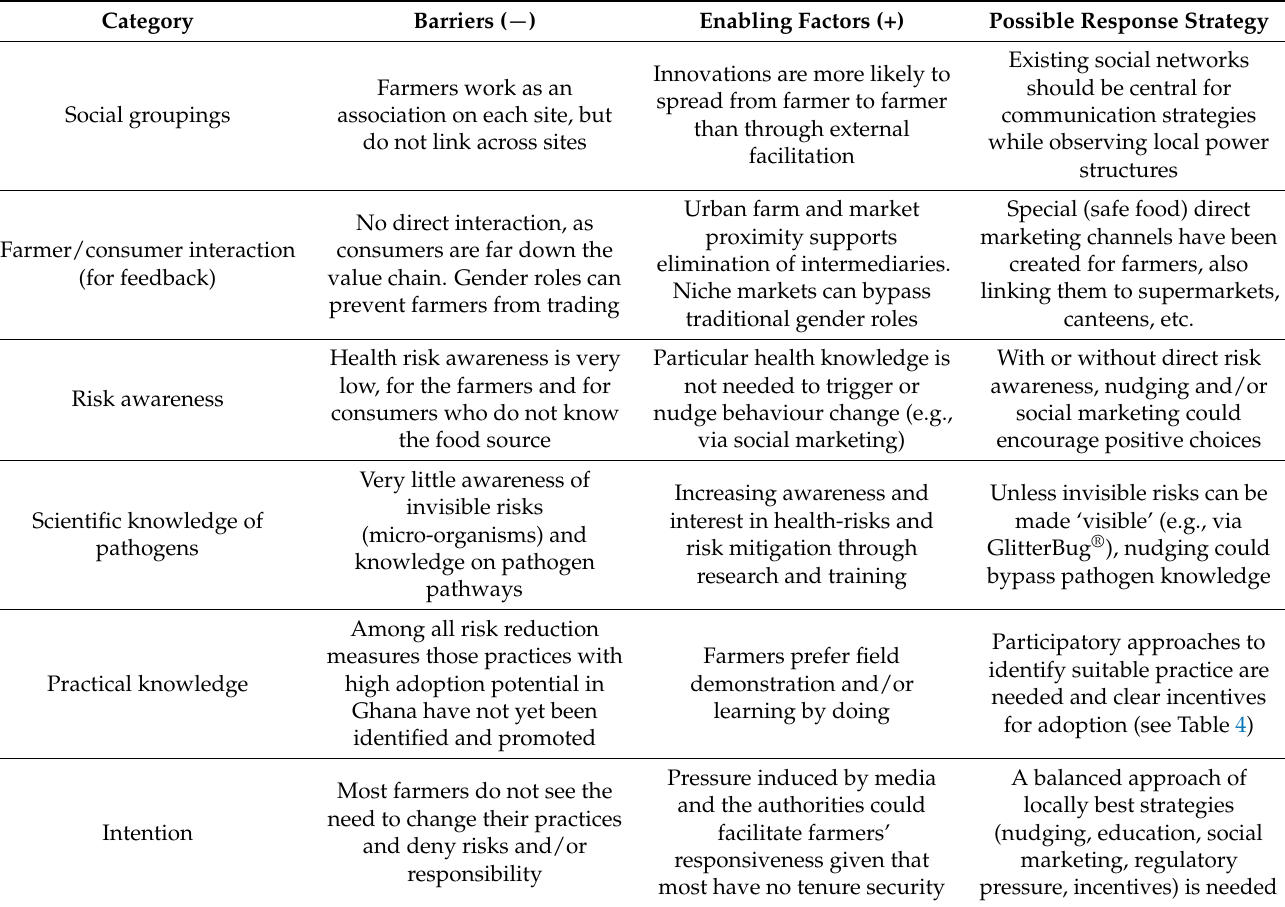
Table 6. Example of external and internal behaviour determinants and possible intervention